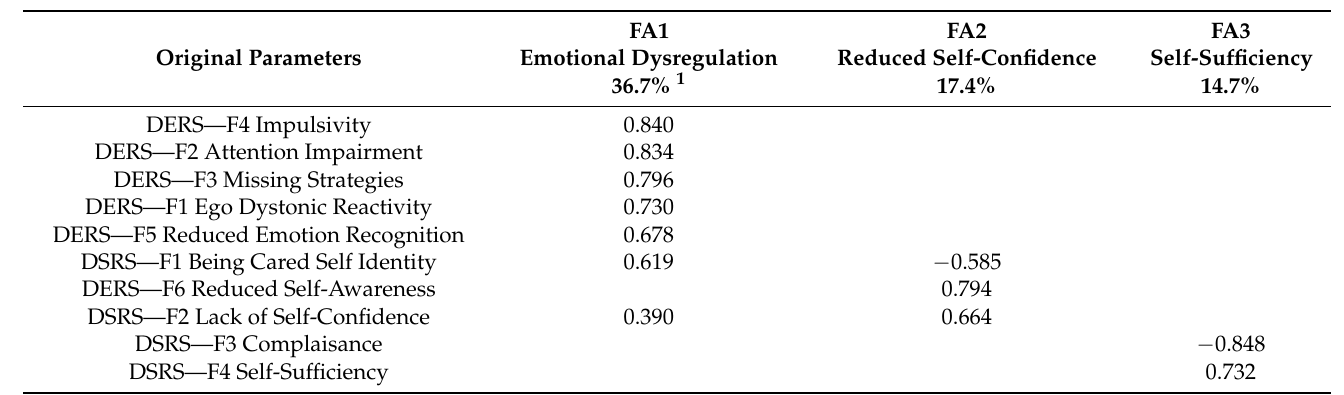
Table 7. Factorial analysis of Affective Dysregulation (DERS) and Affective Dependence (DSRS) subscores.